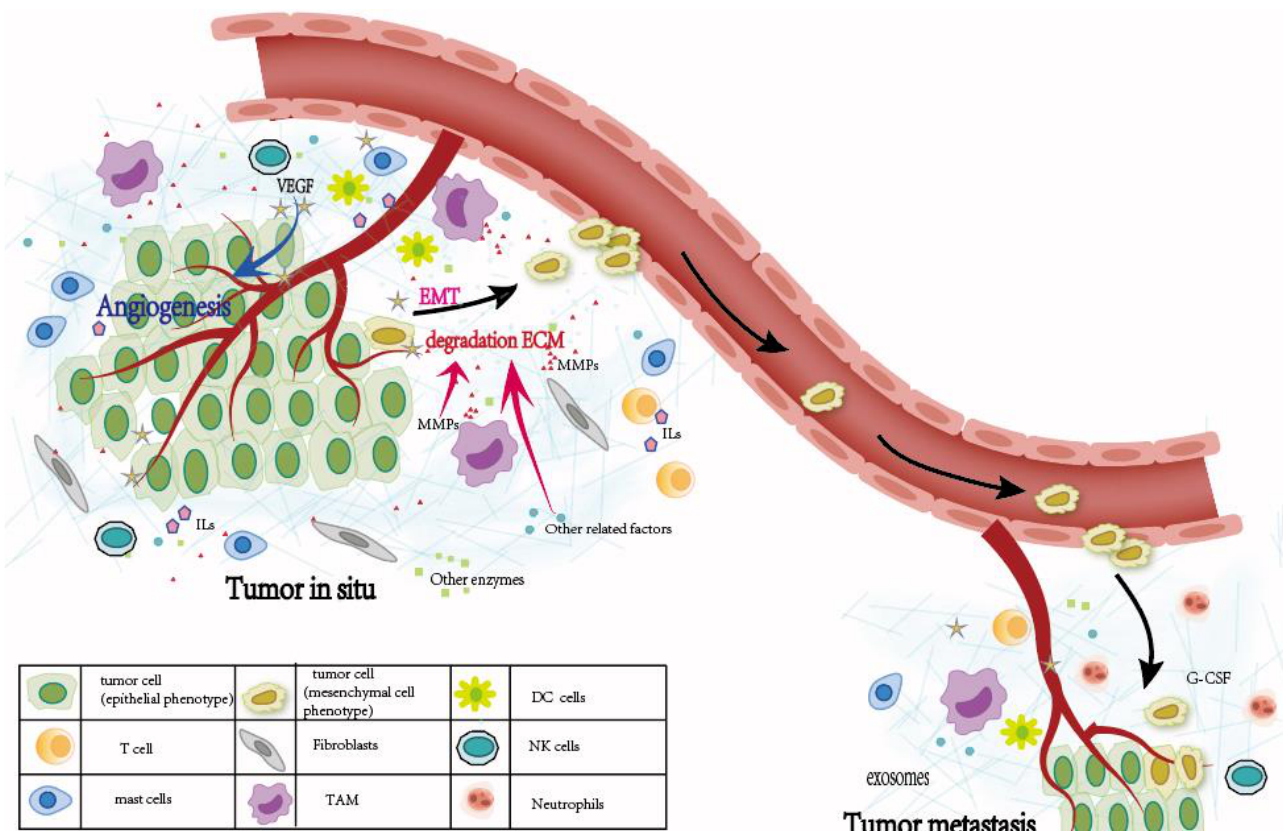
Figure 1. Macrophages, mast cells, NK cells, neutrophils and other TIICs are involved in all aspects of tumor metastasis, including EMT of tumor cells, ECM degradation in tumor microenvironment, angiogenesis around tumor, and the creation of microenviron- ment before tumor metastasis. (TAM = Tumor-associated macrophages; DCs = Dendritic cells; NK cells = natural killer